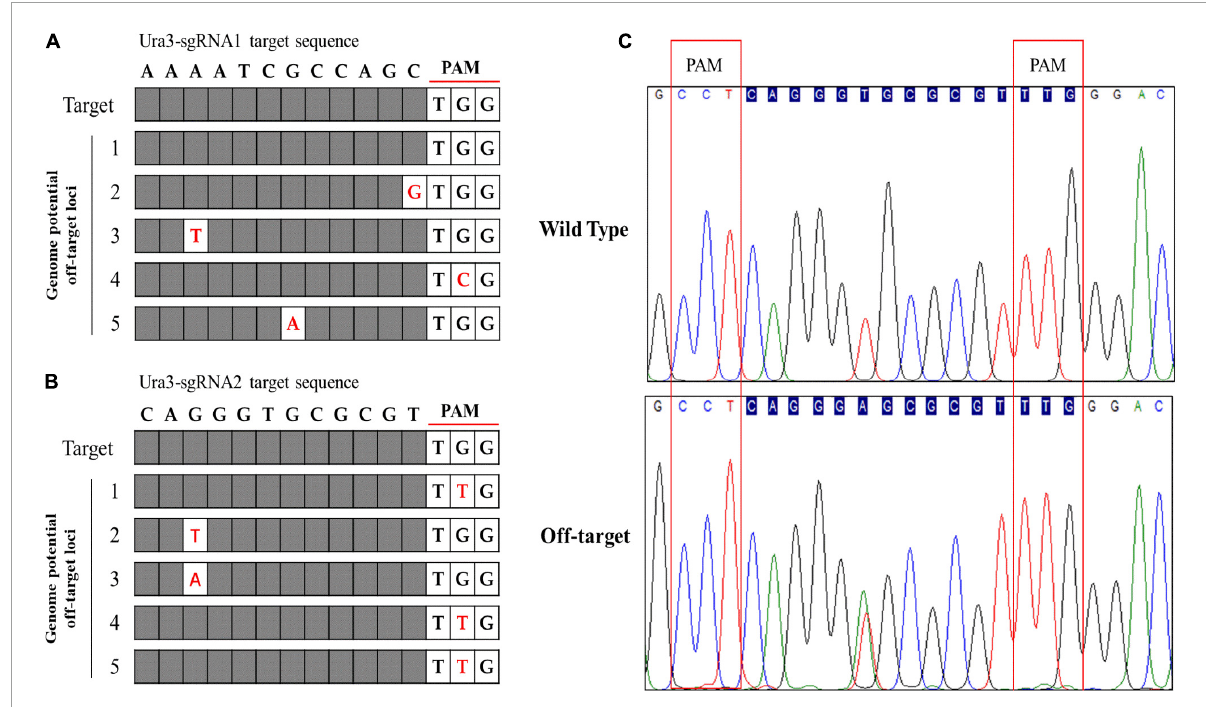
FIGURE7 Genome-wide potential off-target prediction with no or one mismatch and sequencing detection; (A) the potential off-target site of Ura3-sgRNA1; (B) the potential off-target site of Ura3-sgRNA2; and (C) sequencing chromatogram of the detected off-target region comparing the mutant strain to the wild type